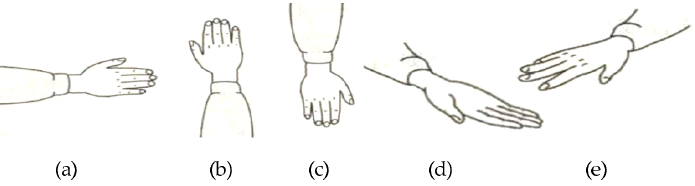
Figure 5. Illustration of gesture segmentation. Table 3. Eleven typical handshape subclasses.